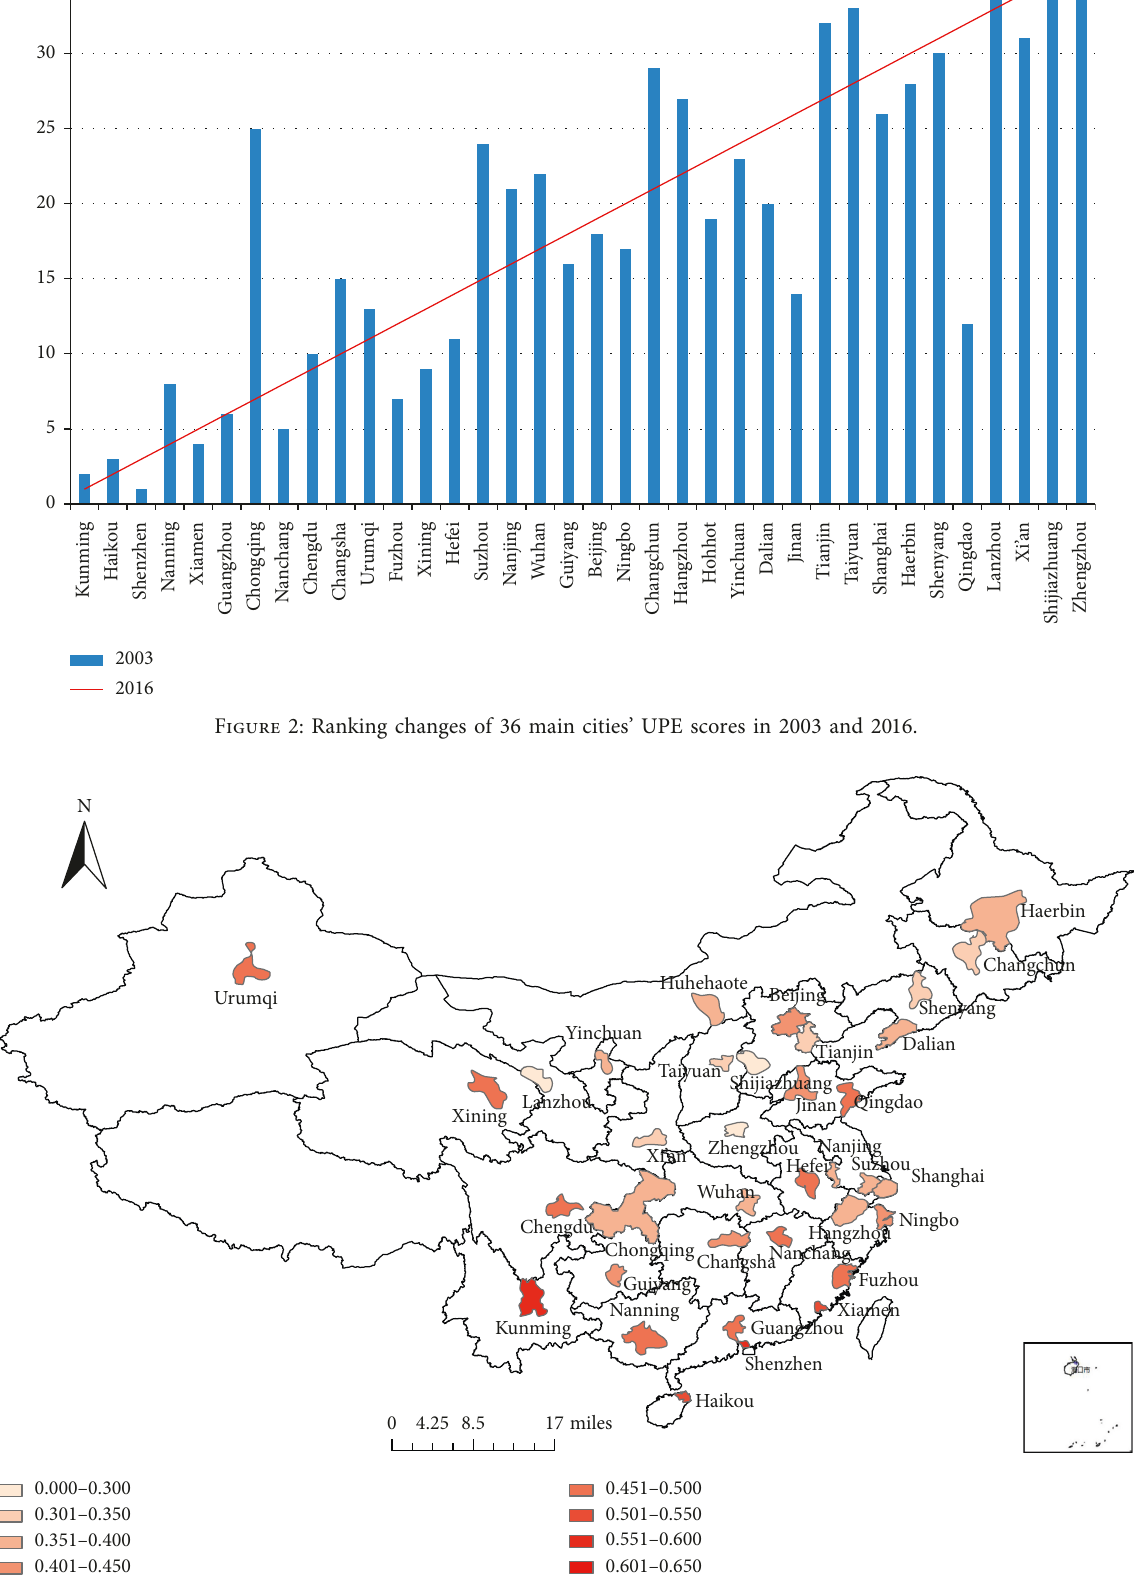
Figure 3: Spatial distribution of 36 main cities’ UPE scores in 2003.